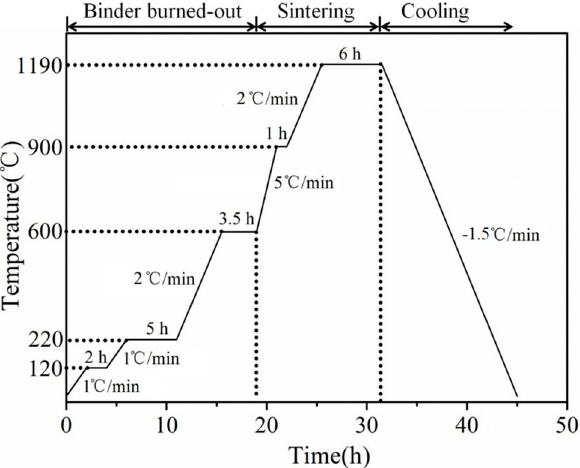
Figure 1. Sintering process of the ceramic cores.